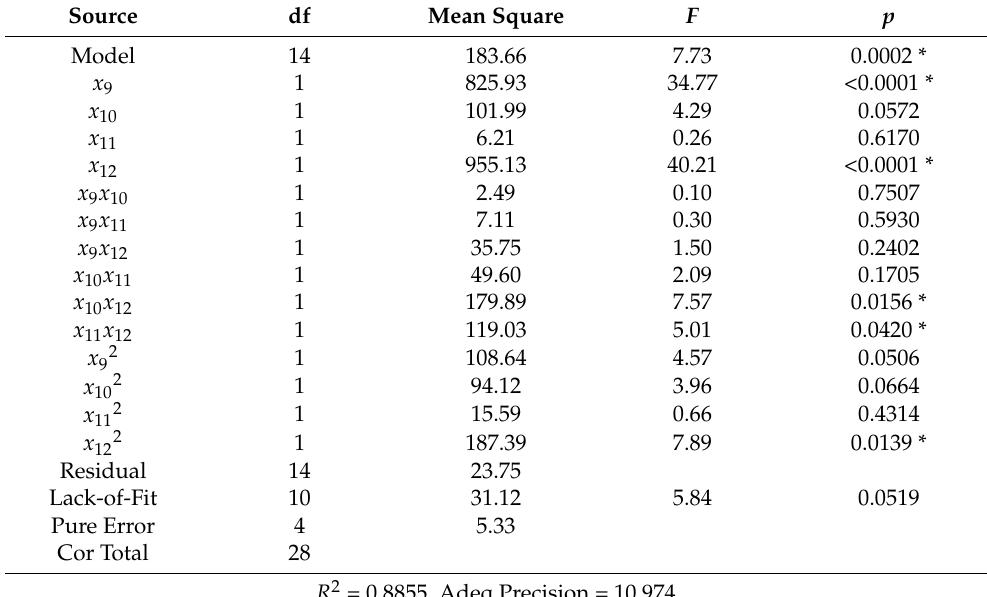
Table 10. ANOVA of the regression model of θ M